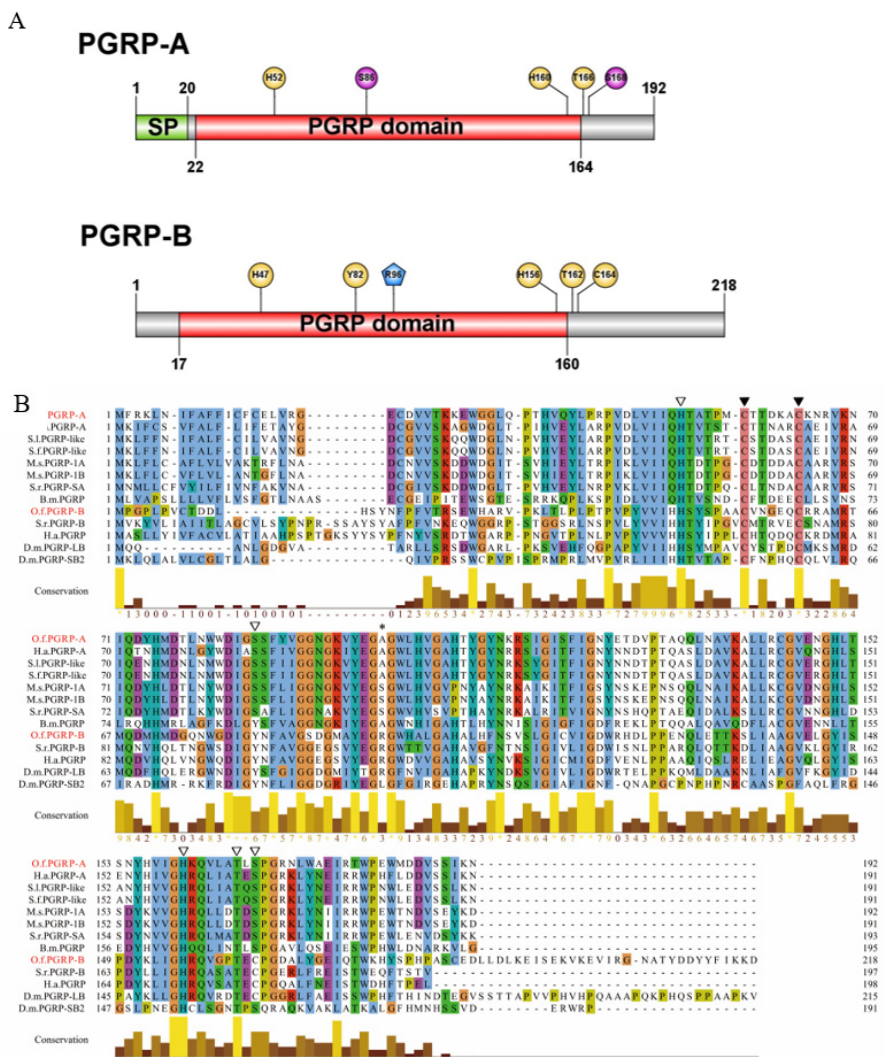
Figure 1. ( A ) Schematic presentation of the protein structure of OfPGRP-A and OfPGRP-B . Signal peptides (SP) and peptidoglycan recognition protein (PGRP) domain are indicated with green and red, respectively. Yellow circles and purple circles represent key amino acid sites that determine zinc ion/amidase activity and mutation sites, respectively. Blue pentagon represents key DAP-type amino acid sites. ( B ) Multiple-sequence alignment of OfPGRP-A and OfPGRP-B with other insect PGRPs. Ha: Helicoverpaarmigera ; Ms: Manduca sexta ; Sl: Spodopteralitura ; Sf: Spodopterafrugiperda ; Sr: Samiaricini; Bm : Bombyx mori ; Dm : Drosophila melanogaster . Key amino acid sites that determine zinc ion/amidase activity, conserved cysteine sites, and * key DAP-type amino acid sites.